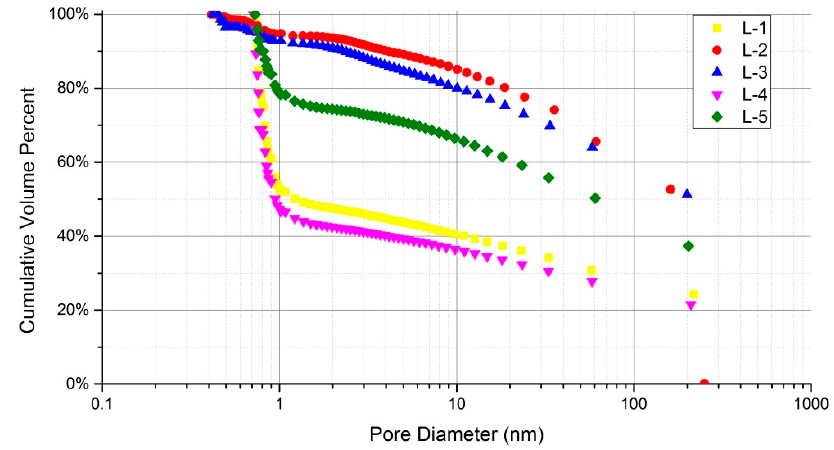
Figure 5. Pore size distribution by percent cumulative volume for the five selected samples in Table 1. Notice that we use logarithmic coordinates on the X -axis.